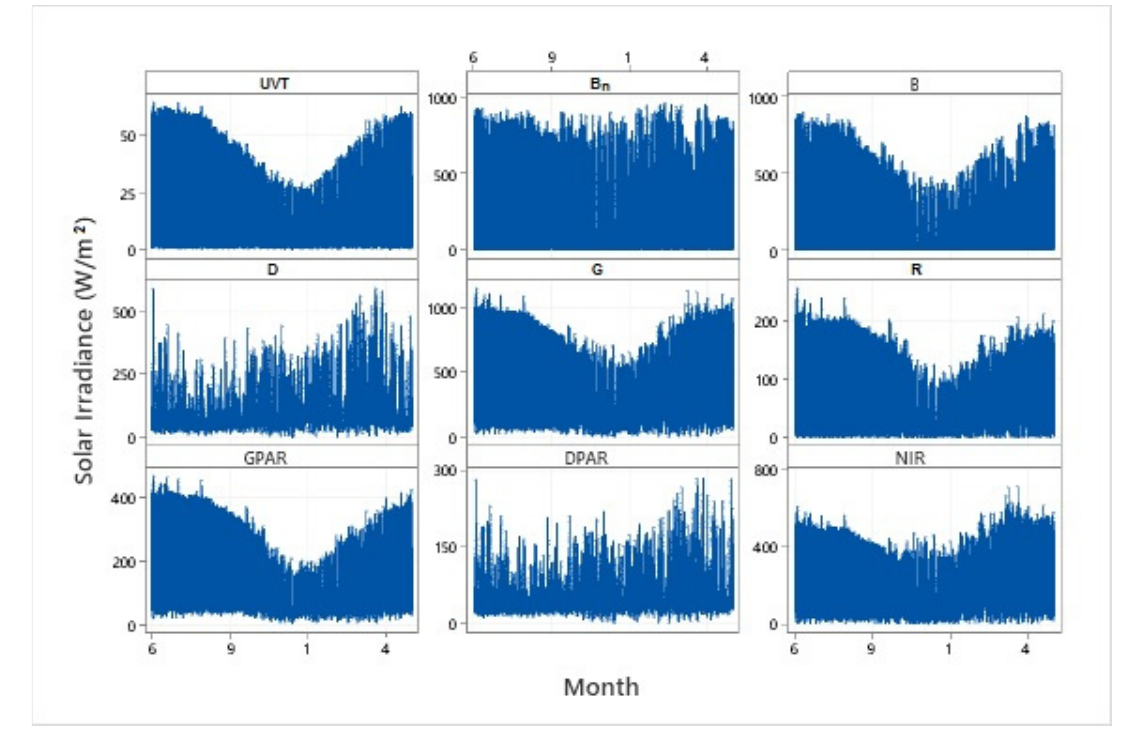
Figure 4. Time series plots of solar shortwave radiation components during the period June 2020–May 2021.